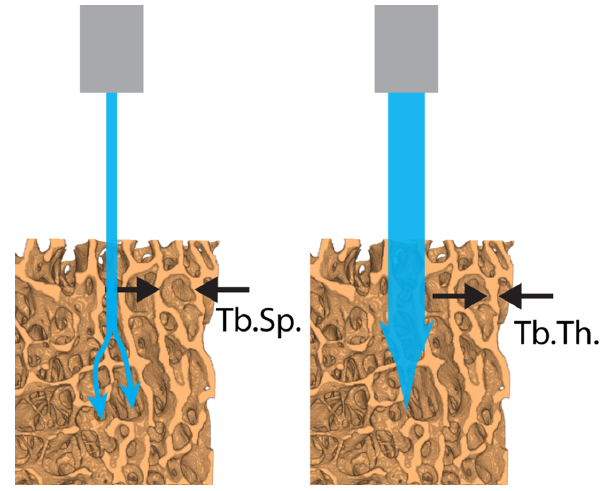
Figure 1. The potential cause for a change in efficiency of a water jets with a smaller diameter than the Tb.Th. or Tb.Sp. The water takes the path of the least resistance in the spacing between the tra- beculae without breaking the